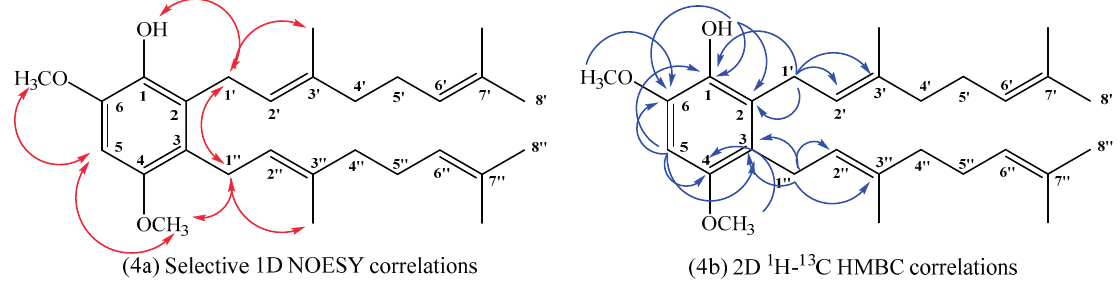
Figure 4. Main correlations observed for compound 15 , selective 1D NOESY ( 4a ), and 2D 1 H– 13 C HMBC ( 4b